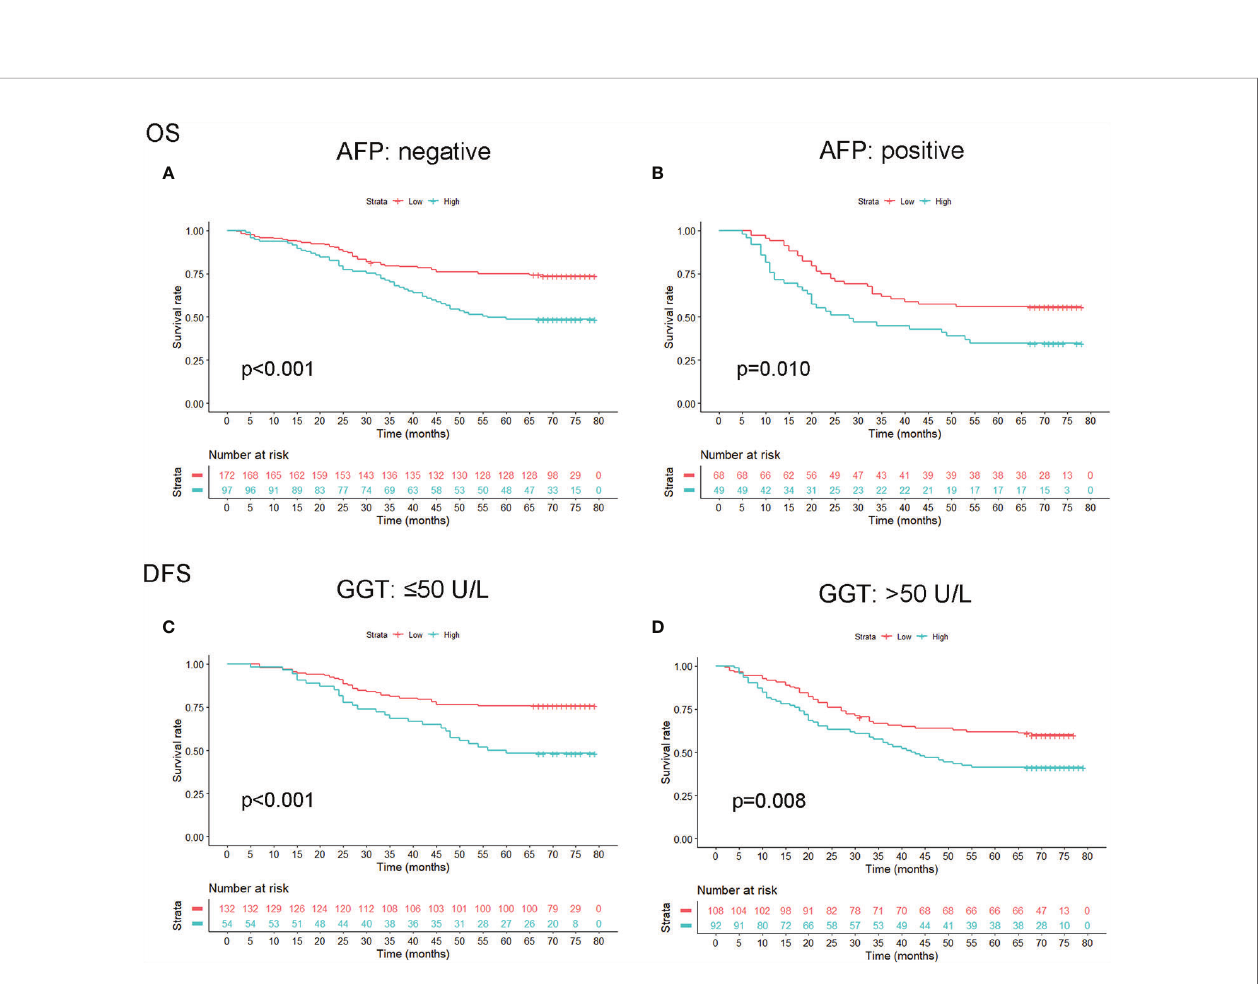
FIGURE 6 | The effect of OPG on HCC patients ’ OS (A, B) and DFS (C, D) strati fi ed by AFP and GGT.